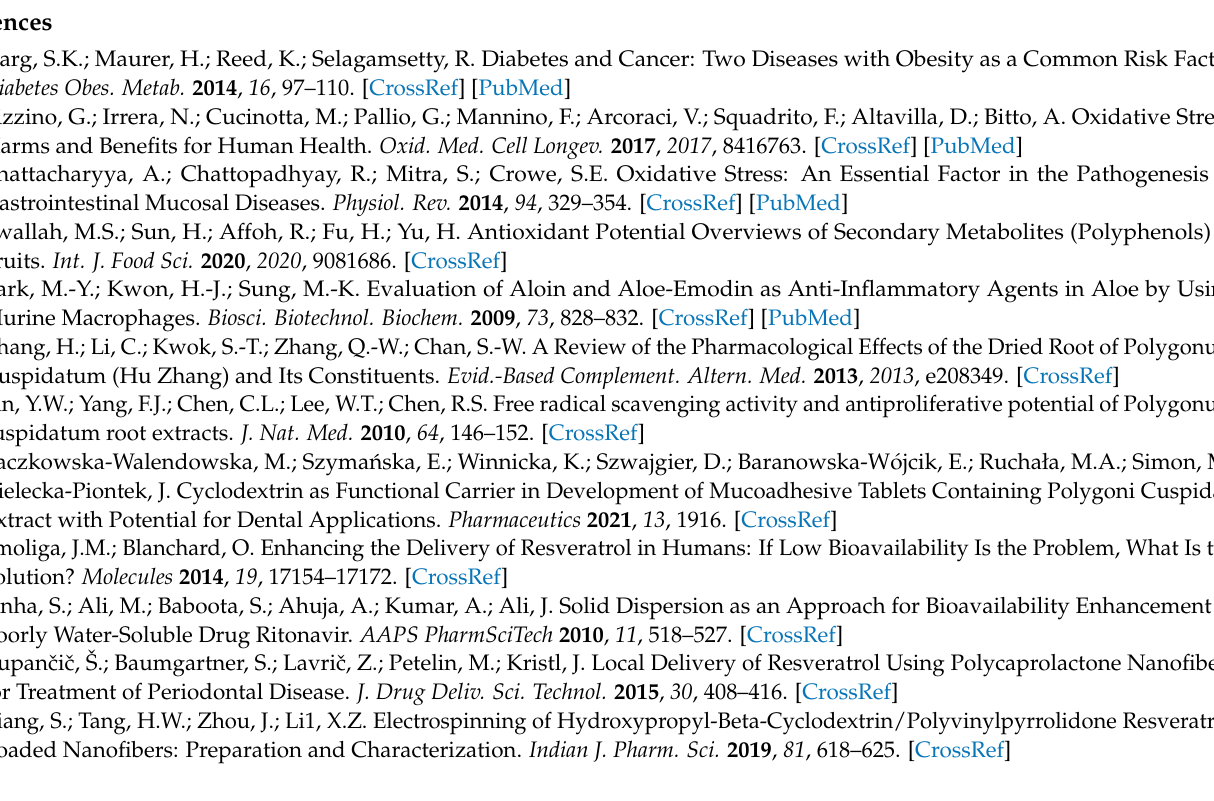
Pareto plot of standardized effects for the sum of active compounds; Figure S2: Pareto plot of standardized effects for the TPC; Figure S3: Pareto plot of standardized effects for the antioxidant activity using DPPH assay; Figure S4: Pareto plot of standardized effects for the anti-hyaluronidase activity; Figure S5: Pareto plot of standardized effects for content of polydatin (a) and resveratrol (b) dissolved in methanol, and polydatin (c) and resveratrol (d) dissolved in artificial saliva solution at pH 6.8; Figure S6: Pareto plot of standardized effects for the total amount of released polydatin (a) and resveratrol (b) from nanofibers at 15 min; Figure S7: Pareto plot of standardized effects for component of bioadhesion; Figure S8: Pareto plot of standardized effects for the apparent permeability coefficients of polydatin (a) and resveratrol